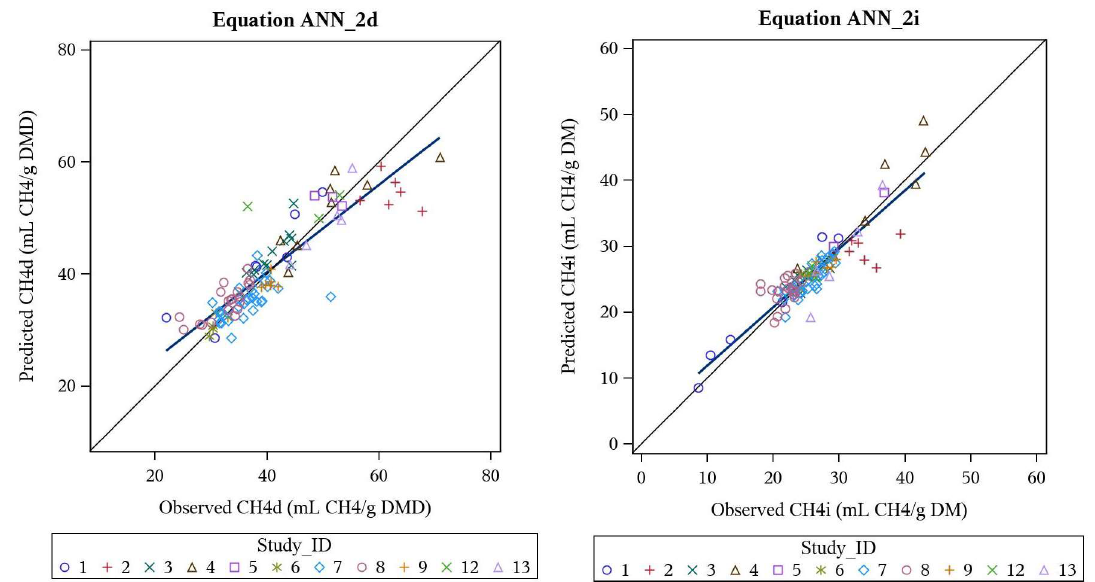
Figure 2. Predicted vs. observed plots for the machine learning equations SVR_1d (CH 4 d), SVR_1i (CH 4 i), ANN_2d (CH 4 d) and ANN_2i (CH 4 i), as evaluated on the evaluation dataset ( n = 107).